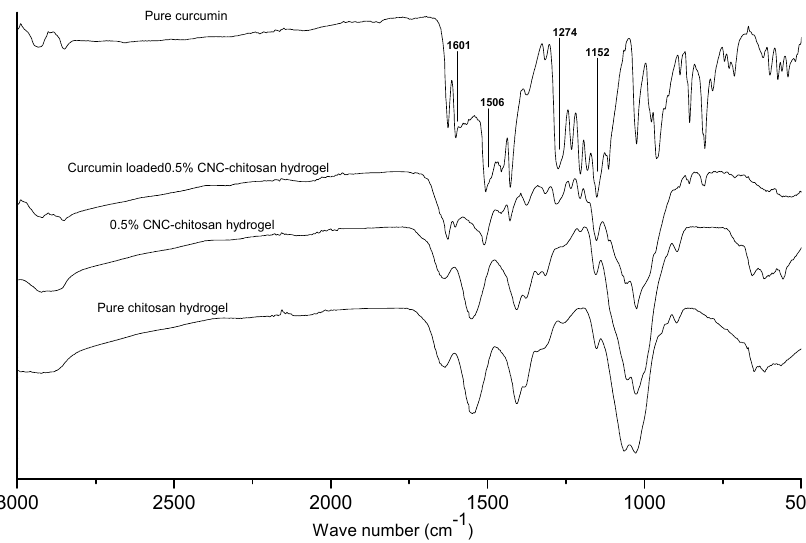
Figure 2. FTIR spectra of pure chitosan hydrogel, 0.5% CNC–chitosan hydrogel, curcumin loaded 0.5% CNC–chitosan hydrogel and pure curcumin.